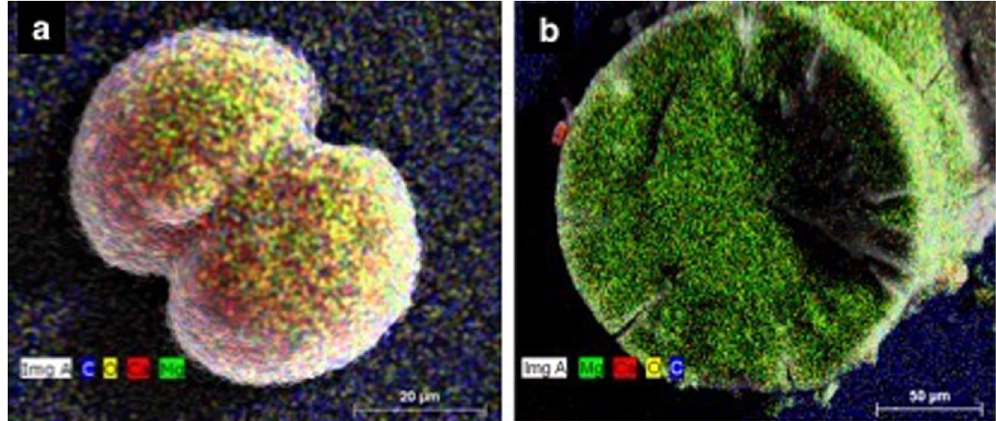
Figure 2. Representative EDS elemental maps showing the distribution of elements in crystals recovered from DF112 and DF241 pure cultures. ( a ) High magnesium calcite crystal. ( b ) Hydromagnesite crystal.